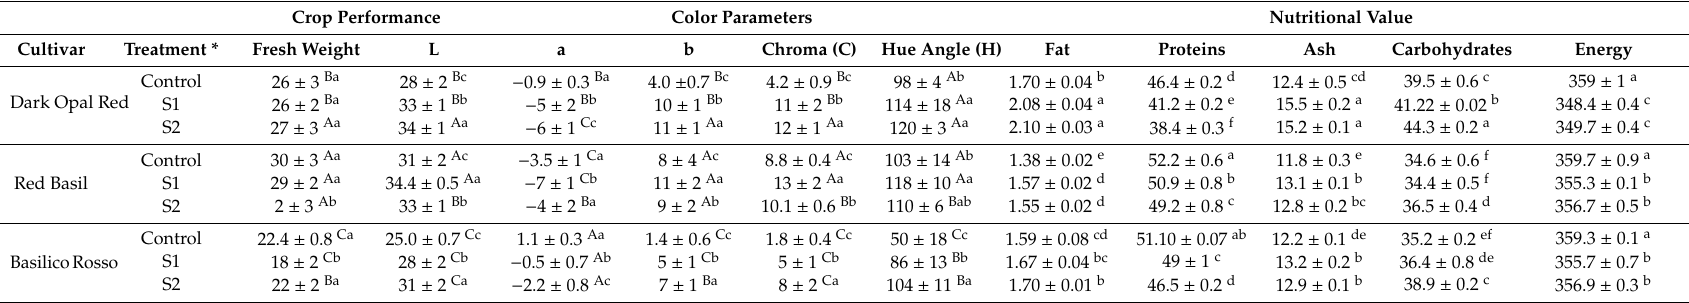
Table 1. Crop performance (fresh weigh per plant, g / plant), color parameters ( L, a, b , Chroma and Hue angle, mean ± SD; n = 15) , nutritional (g / 100 g dw) and energetic value (kcal / 100 g dw) of the tested basil cultivars in relation to salinity level (mean ± SD; n =